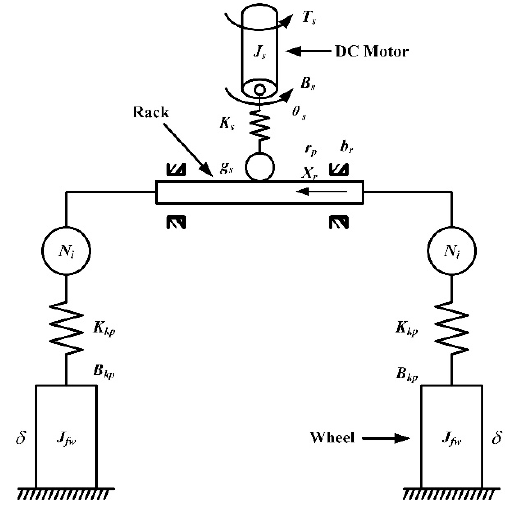
Figure 4. SBW system model. Table 3. Parameters of the SBW model